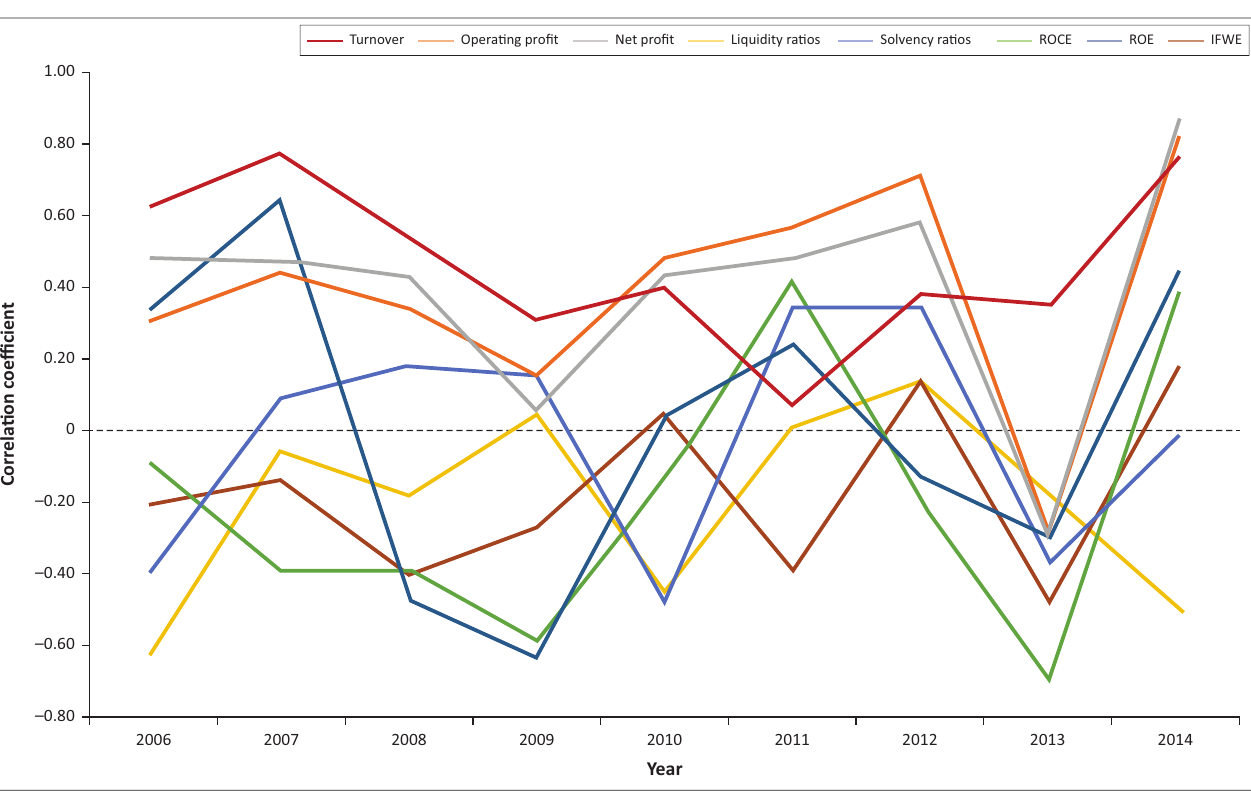
FIGURE 1: Fixed pay and state-owned companies’ performance. ROCE, return on capital employed; ROE, return on equity; IFWE, irregular, fruitless and wasteful expenditure.